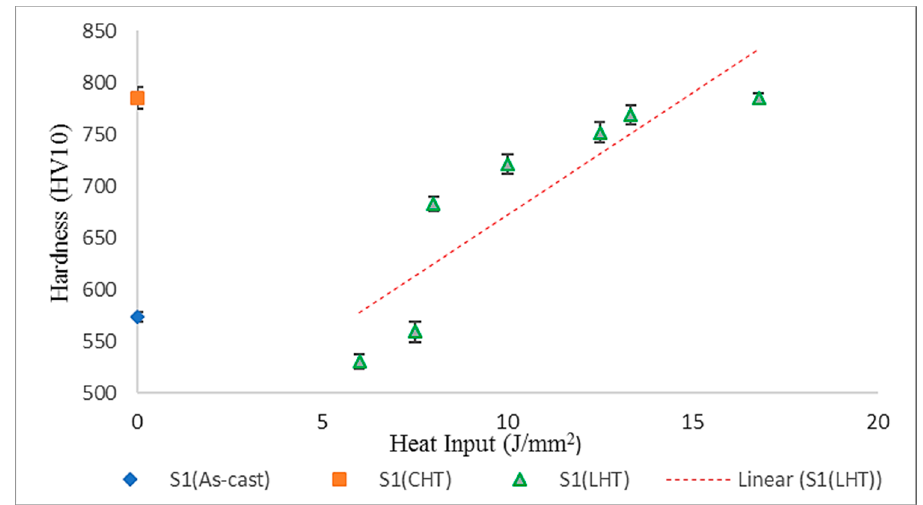
Figure 12. Hardness average values of LHT (S1 sample), CHT and As-cast samples. Error bars represent standard deviation.